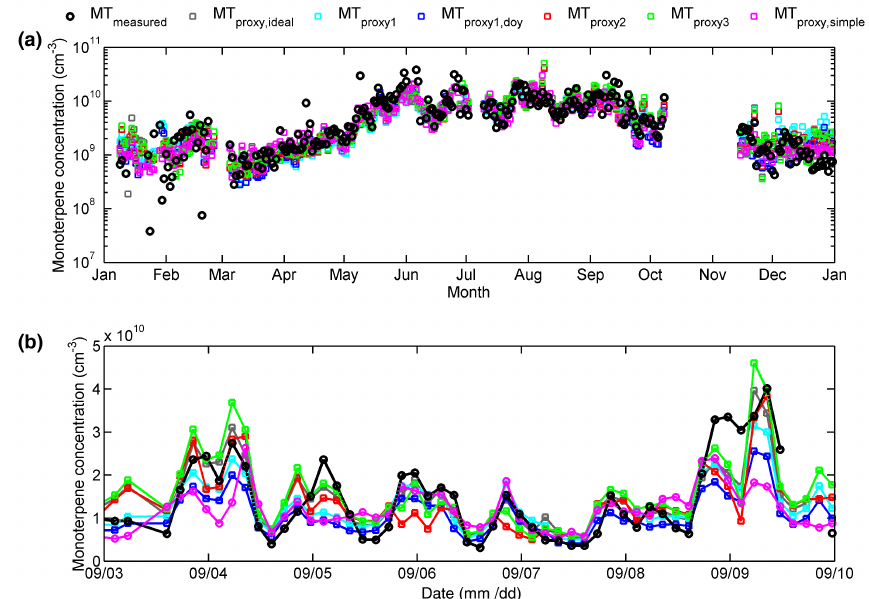
Figure 4. Time series of the measured monoterpene concentration and the concentrations predicted by different proxies (a) for the whole year 2013, (b) for 1 week in September 2013. The black circles show the measured concentration, the gray squares show MT proxy , ideal , the light blue squares MT proxy1 , the dark blue squares MT proxy1 , doy , the red squares MT proxy2 , the green squares MT proxy3 and the magenta squares MT proxy , simple